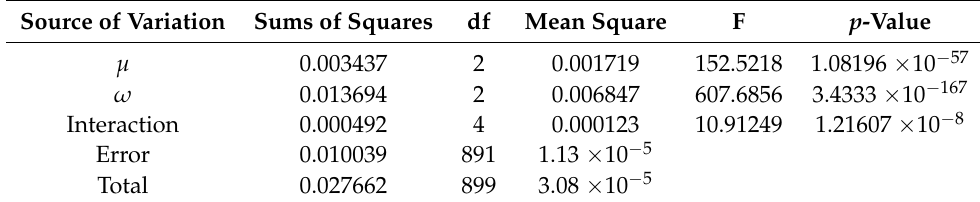
Table 2. The variance analysis of the two parameters on the calculation